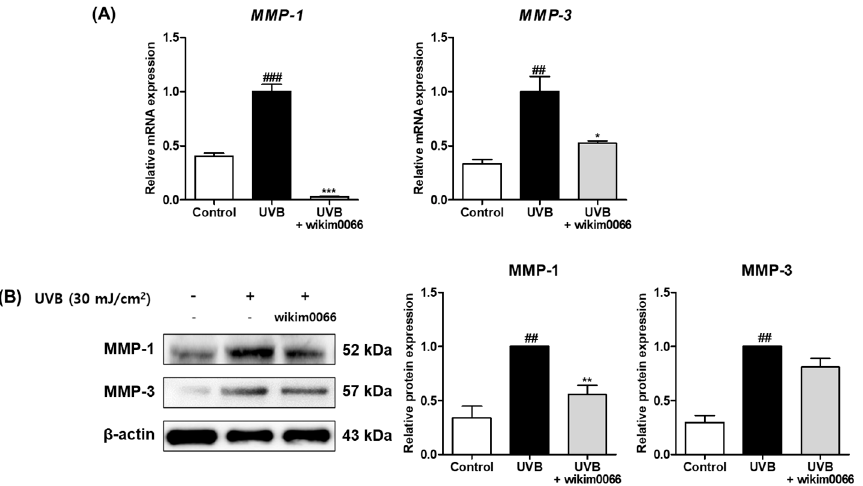
Figure 3. Effect of CFS from wikim0066 on mRNA expressions ( A ) and protein expressions ( B ) of MMP-1 and MMP-3 in UVB-irradiated Hs68 cells. Cells were pretreated with 10% CFS and irradi- ated with UVB (30 mJ/cm 2 ), then treated with fresh culture medium containing 10% CFS for 48 h. The mRNA intensities were normalized to that of GAPDH, and proteins were normalized to that of β -actin. Results are presented as the mean ± SEM ( n = 3). ## p < 0.01, and ### p < 0.001, vs. control and * p < 0.05, ** p < 0.01, and *** p < 0.01 vs.